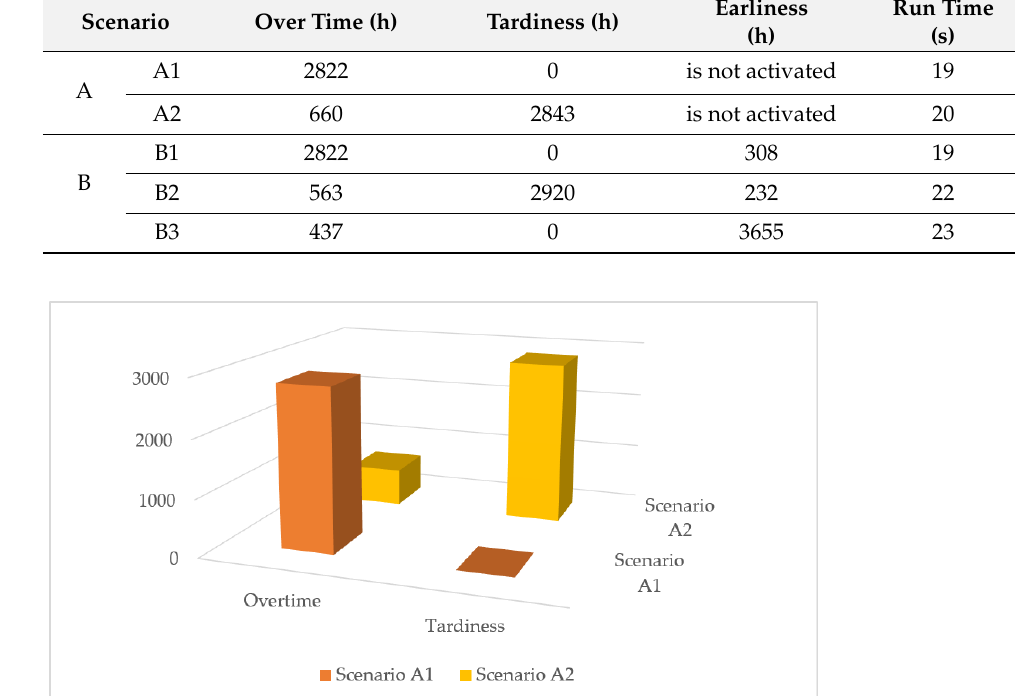
Figure 12. The comparison between Scenario A1 and A2.